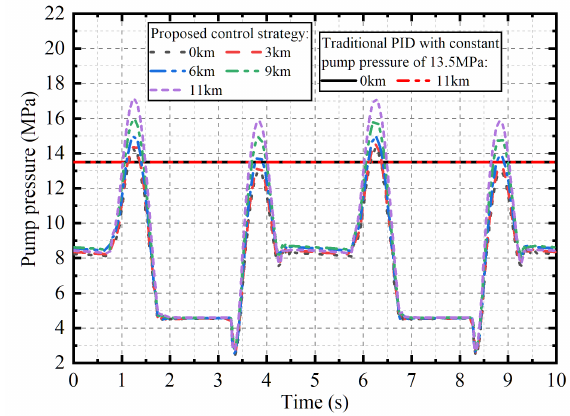
Figure 10. Pump pressure of multi-step movement.